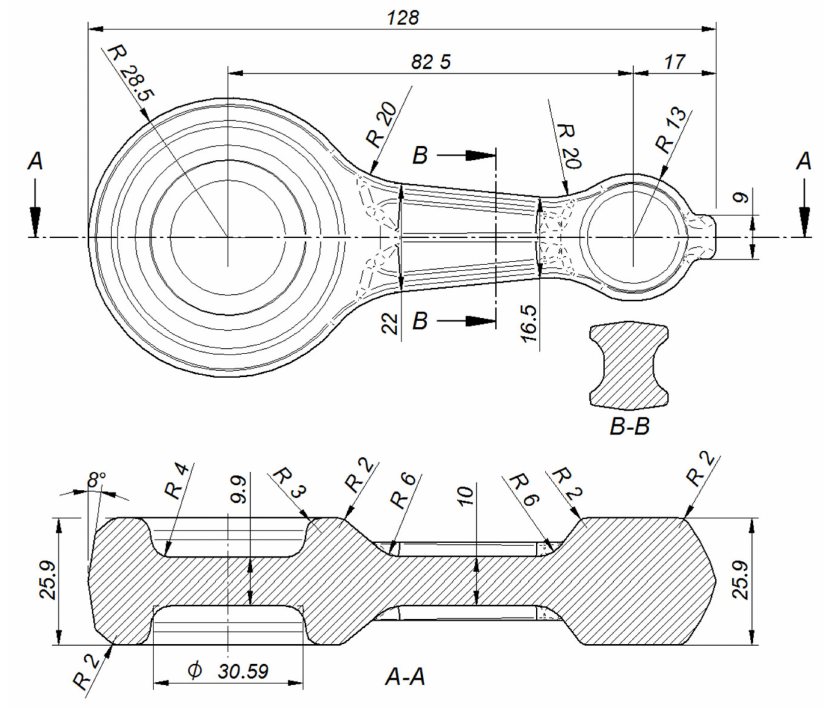
Figure 8. Selected dimensions of the variant 2